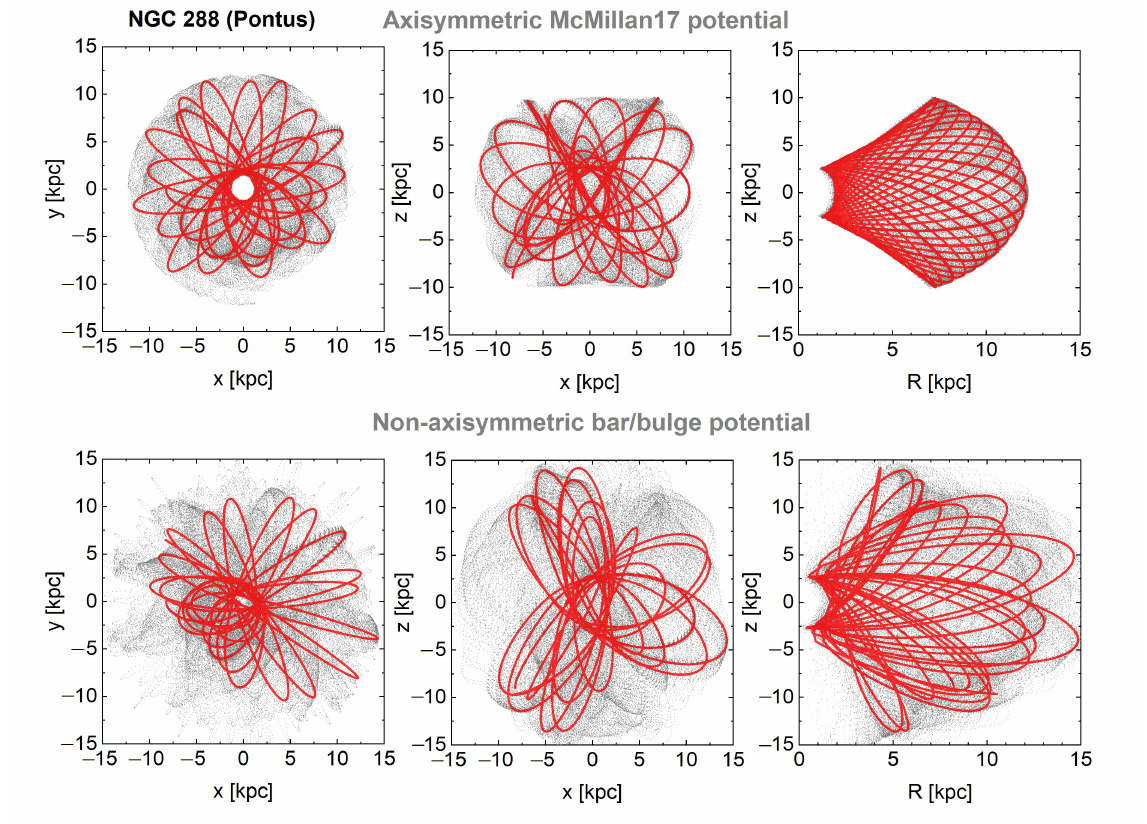
Figure 8. Projections of the cluster orbits onto the galactocentric coordinate planes for the axisym- metric potential McMillan17 ( top frames) and for the non-axisymmetric potential of the rotating bar ( bottom frames). The red lines show the orbit for the mean initial conditions, whereas the grey lines show one hundred orbits consistent with the observational errors in these initial